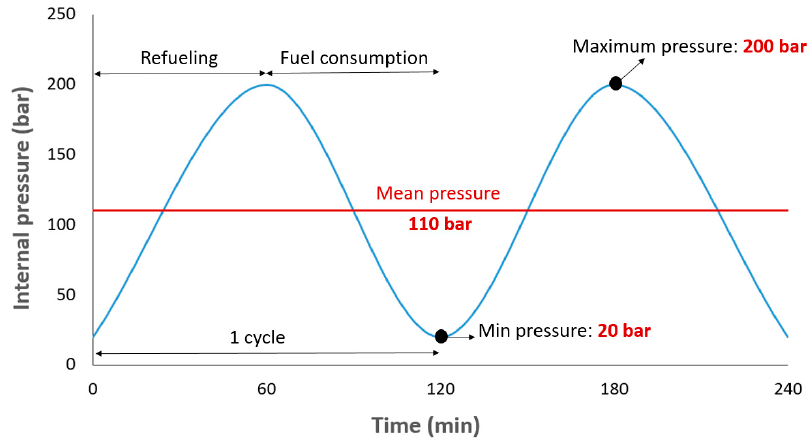
Figure 5. Details of the cyclic loading used to predict the fatigue life of the CNG fuel tank.